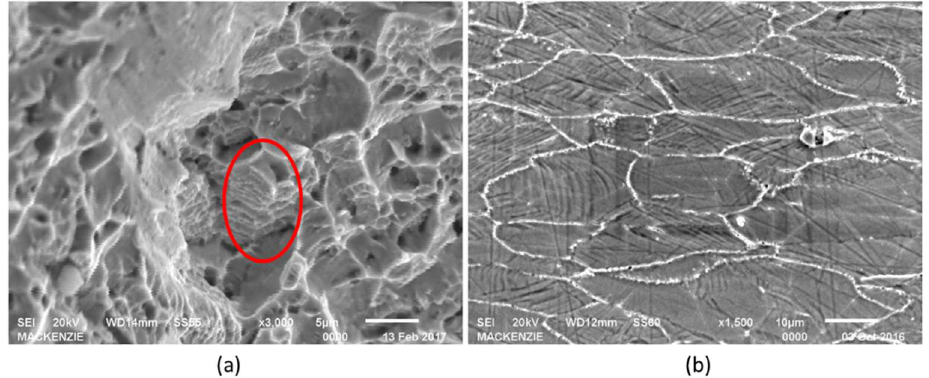
Figure 10. Micrographs of the Inconel 625 tensile tested at 700 °C: ( a ) typical fracture surface with slip bands in evidence and ( b ) longitudinal section of fracture region (3 mm to the fracture) .